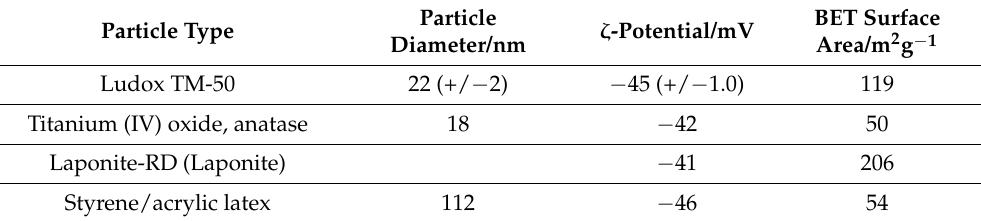
Table 1. Essential characteristics of the particles used in this study. Particle